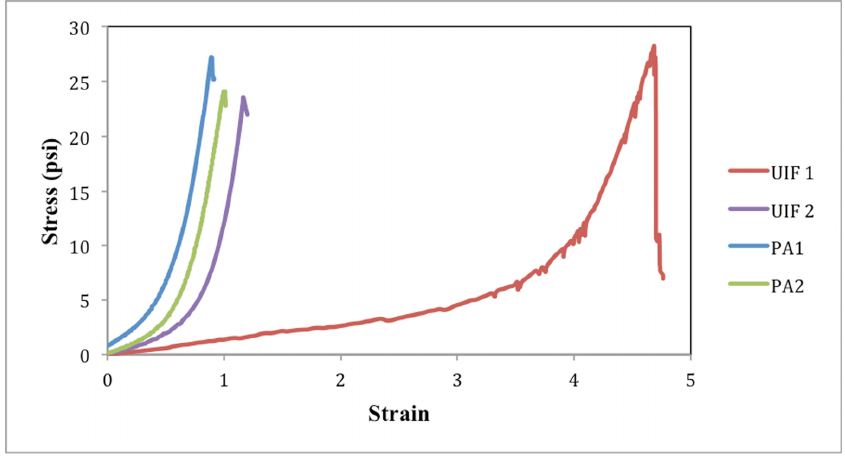
Figure 4. Stress-strain plot of untreated fabric and treated fabric with formulations PA1 and